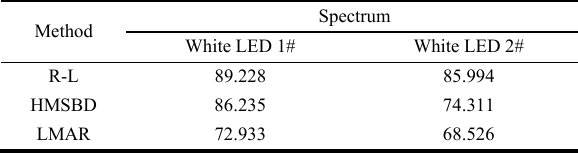
Table 2 RMSEs of all three methods in flat regions of the two